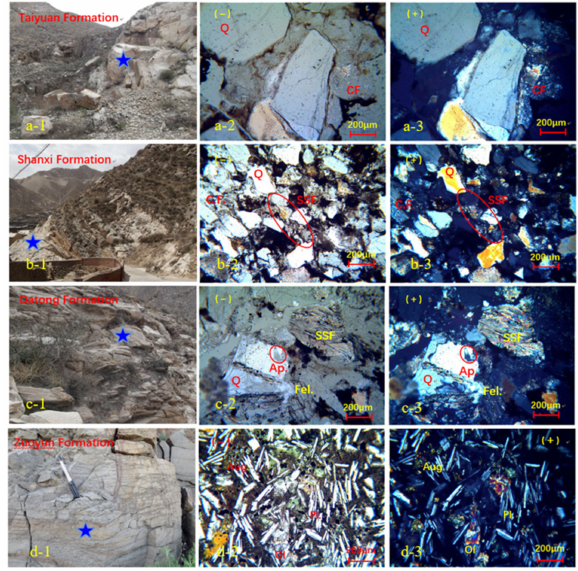
Figure 4. Representative field photographs and photomicrographs of the samples in the Datong basin. ( a ) sandstone from the Taiyuan Formation; ( b ) sandstone from the Shanxi Formation; ( c ) sandstone from the Datong Formation; ( d ) basaltic andesite from the Zuoyun Formation; ( a-2 , b-2 , c-2 , d-2 ) thin section under plane-polarized transmitted light ( − ); ( a-3 , b-3 , c-3 , d-3 ) and under orthogonality